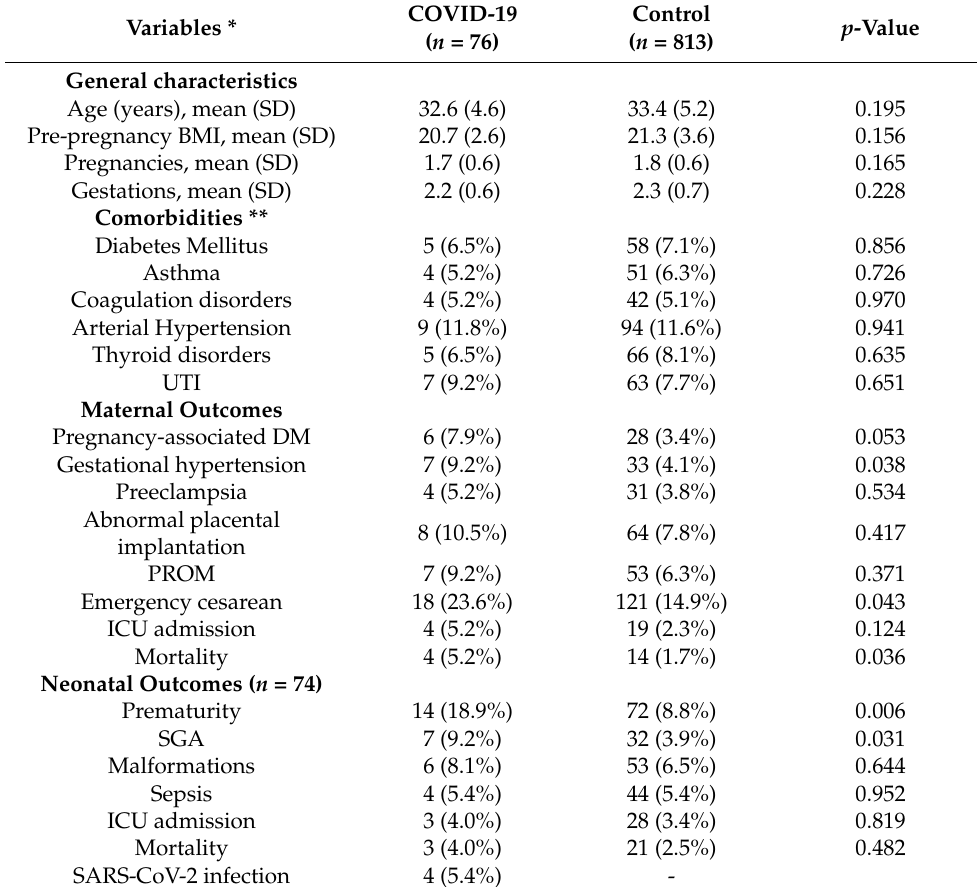
Table 1. General characteristics and outcomes of pregnant women and their neonates participating in this research as compared with a cohort of pregnant women without